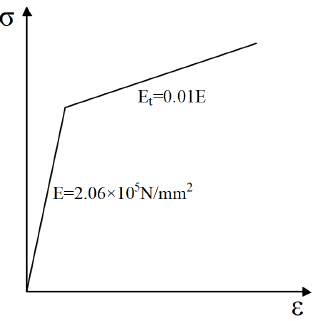
Figure 3. Bilinear isotropic hardening constitutive model.